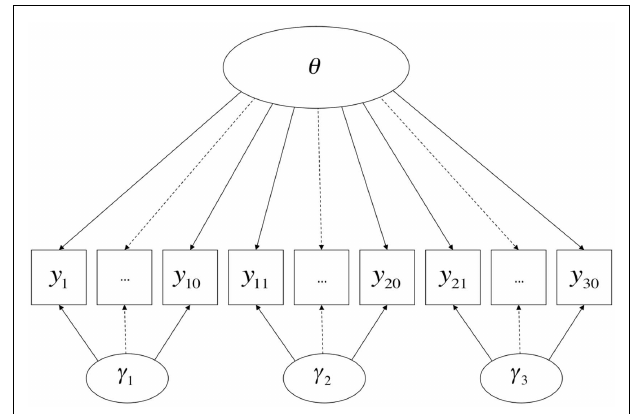
FIGURE 2 |A Bi-factor